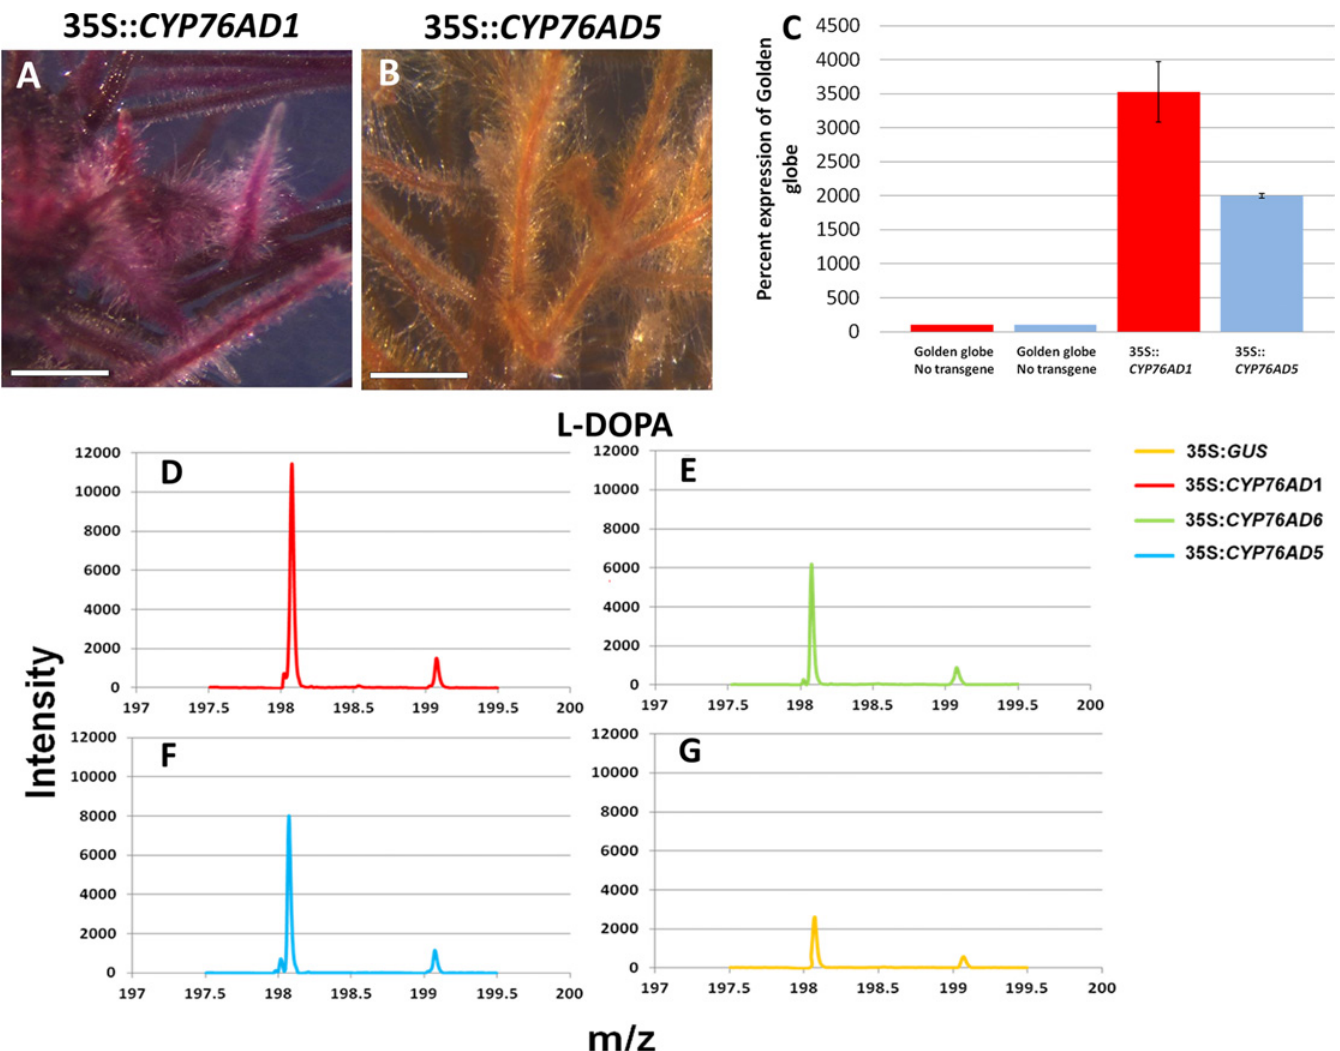
Fig 2. Overexpression of CYP76AD1, CYP76AD6, or CYP76AD5 results in increased L-DOPA content in beet. A. and B. CYP76AD1 complemented, but CYP76AD5 did not complement the rr ( CYP76AD1 ) beet mutant (Golden Globe) from yellow to red. C. qRT-PCR verified that CYP76AD1 and CYP76AD5 were overexpressed in transgenic hairy root cultures. D, E, F, and G. Mass spectrometry analysis of L-DOPA in Golden Globe beet roots overexpressing CYP76AD1, CYP76AD6, CYP76AD5, and GUS, respectively. Error bars are s.d. Each experiment was replicated three times. Scale bars are 3.5